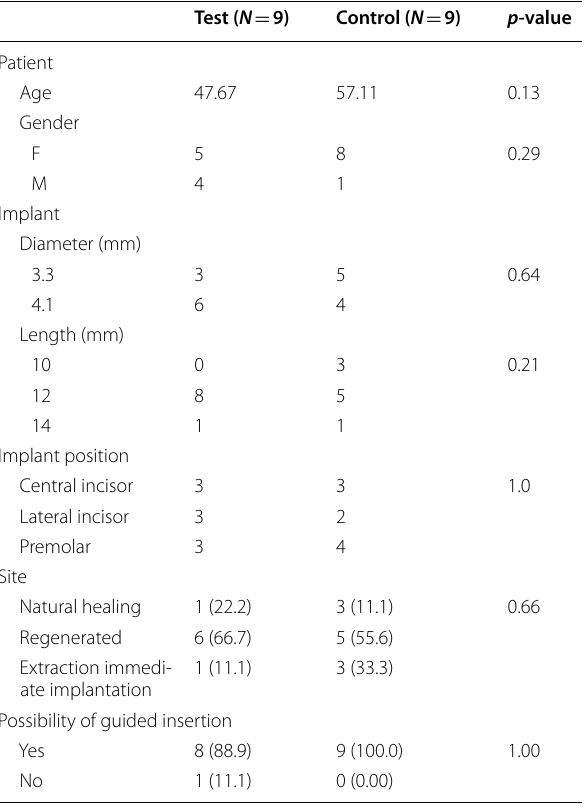
Table 1 Patient and implant related